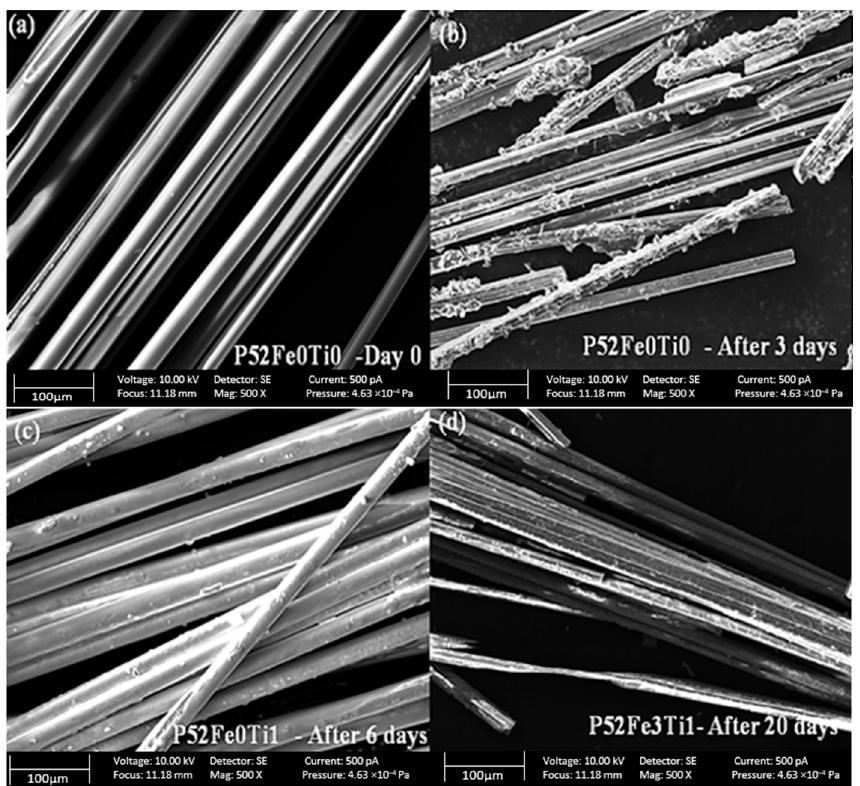
Figure 4. The morphology of PGFs without Fe 2 O 3 /TiO 2 before ( a ), after ( b ) the degradation, and PGFs doped by Fe 2 O 3 /TiO 2 after 6 days ( c ) and 20 days ( d ) of the degradation tests.